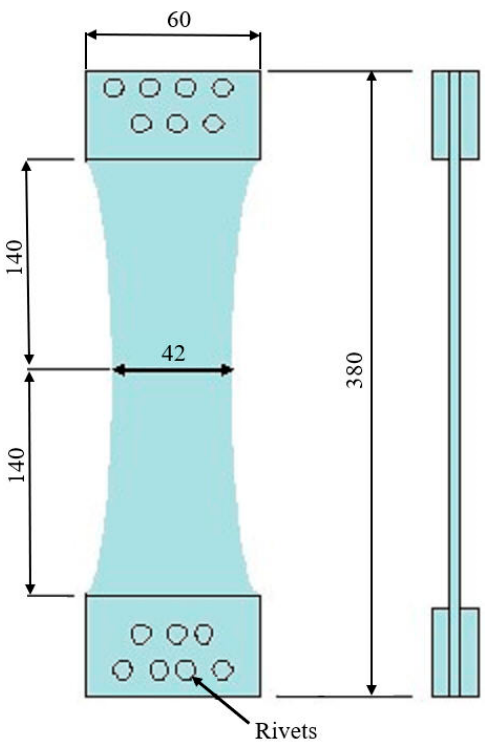
Figure 3. Geometry of the dogbone test specimens.